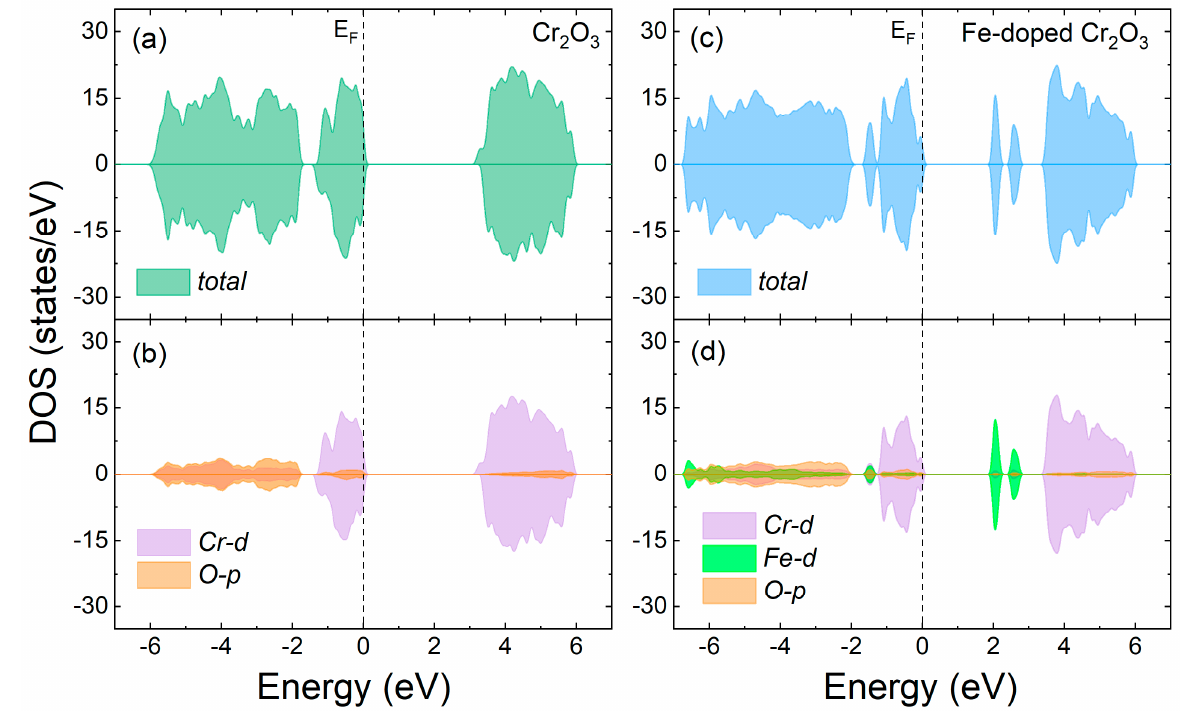
Figure 6. Total (TDOS) and projected spin-polarized density of electronic states (PDOS), as calculated using TB-mBJ exchange–correlation potential: ( a , b ) the TDOS and PDOS of Cr 2 O 3 , respectively; ( c , d ), the TDOS and PDOS for Fe-doped Cr 2 O 3 , respectively. The dashed black line is the Fermi energy level, and the positive and negative values represent the states with the spin polarization moving up and down, respectively.